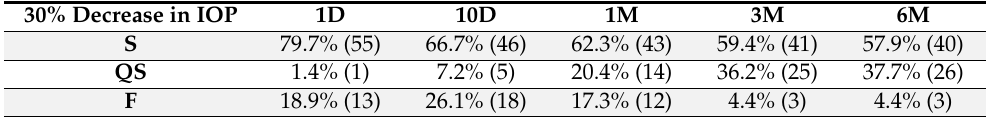
Figure 2. Changes in best corrected visual acuity during the study. Table 3. Success criteria 2: intraocular pressure lower than 18 mmHg after GATT procedure. Table 2. Success criteria 1: 30% decrease in intraocular pressure after GATT.